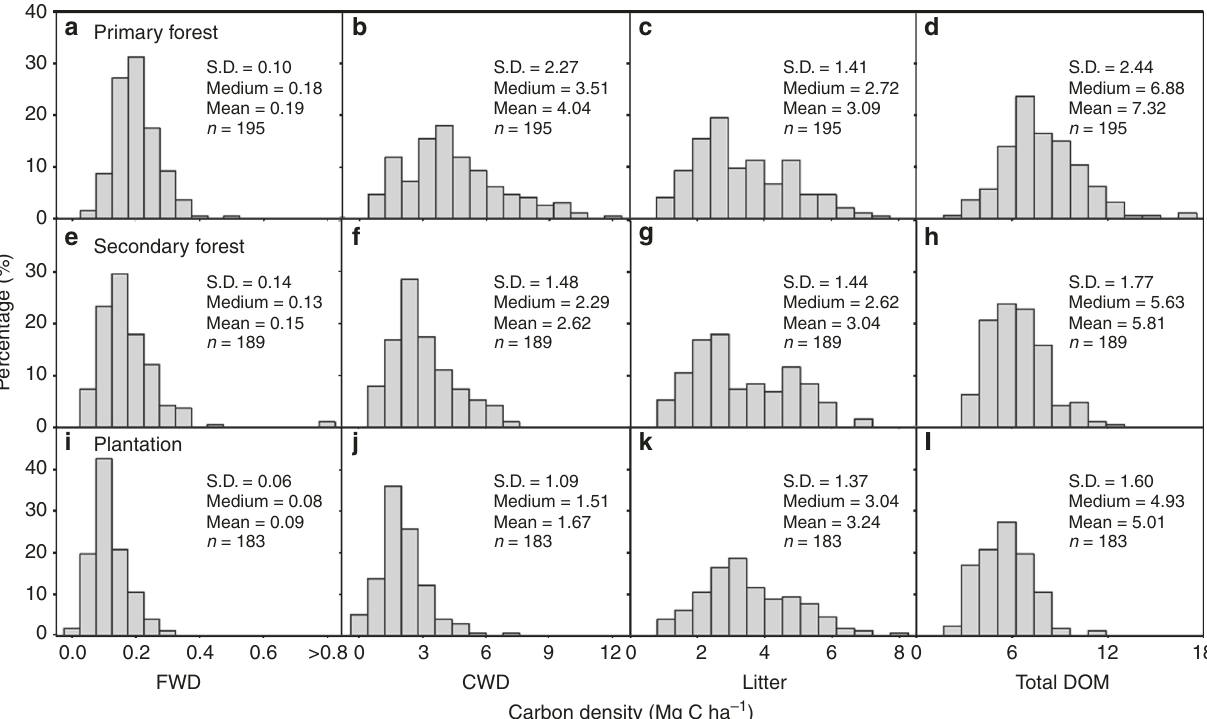
Fig. 2 Frequency distribution of the carbon density of each component of dead organic matter ( DOM ). Frequency distributions are shown for a – d the primary forests, e – h secondary forests, and i – l plantations. Components of dead organic matter d , h and l include fi ne woody debris ( FWD ; a , e and i ), coarse woody debris ( CWD ; b , f and j ), and litter c , g and k Table 1 Area, number of sites, and carbon density of each carbon component for the different forest types a